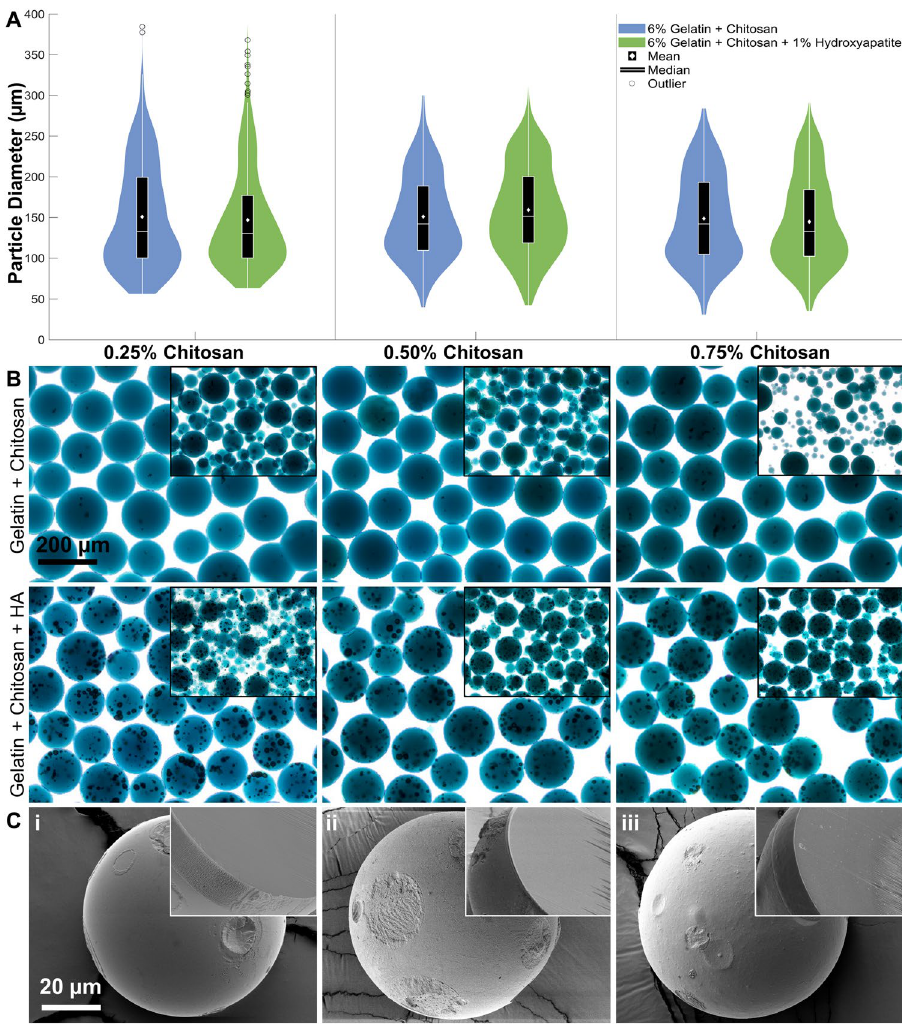
Figure 3. Osteogenic microgel fabrication and characterization. ( A ) Size distribution of gelatin microgels fabrication after adding 0.25, 0.50, or 0.75 wt% chitosan and 1 wt% hydroxyapatite (n ≥ 100). ( B ) Representative bright-field micrographs of the 150–250 µm microgels made from different chitosan and HA concentrations. The HA aggregates can be seen as dark spheroids within the microgels. The insets show the unsorted microgels of each formulation. ANOVA shows no statistical difference between groups. ( C ) Scanning electron micrographs of dehydrated microgels formulations: (i) Gelatin; (ii) Gelatin + 0.25 wt% chitosan; (iii) Gelatin + 0.25 wt% chitosan + 1 wt% hydroxyapatite. (Inset) Cross-section of dehydrated microgels showing a uniform and densely packed matrix with slight variations in the texture between